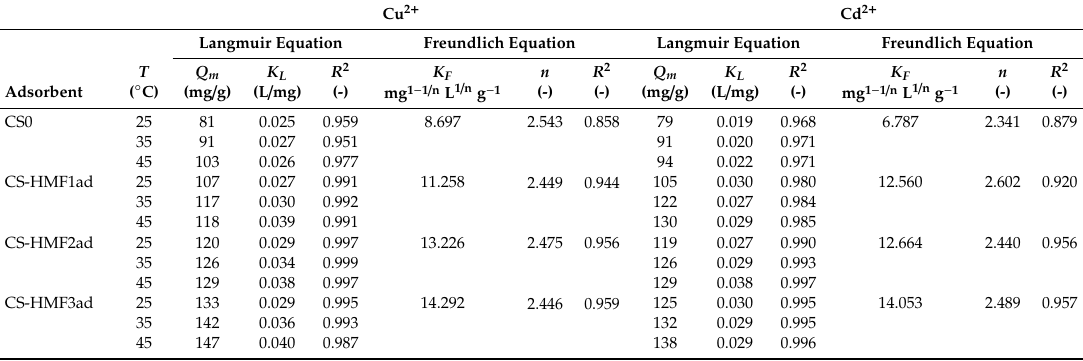
Table 2. Equilibrium parameters for Cu 2 + ad Cd 2 + adsorption onto CS-HMF derivatives. Cu 2 + Cd 2 + Langmuir Equation Freundlich Equation Langmuir Equation Freundlich Equation